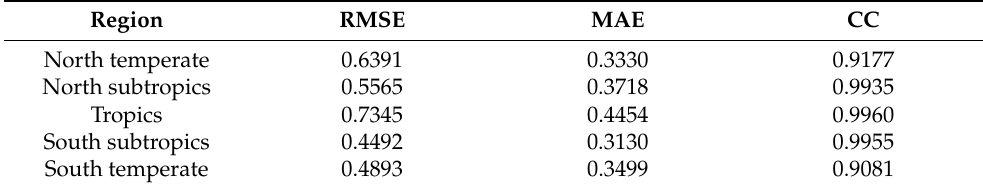
Table 4. Evaluation of the overall prediction performance for the SSbT fields in different geographical